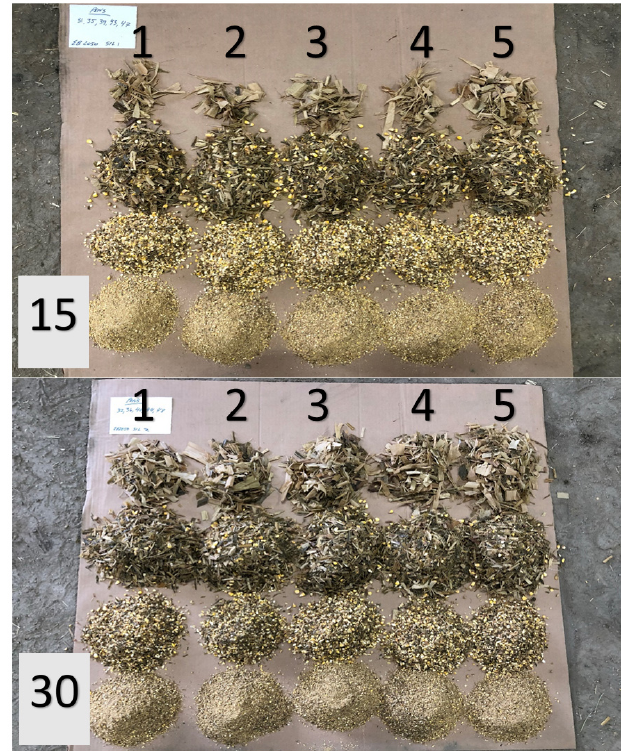
Figure 1. Visual illustration of the batch fraction (1, 2, 3, 4, or 5) and corn silage percentage (dry matter basis) fed (15 or 30) for the diets that were mixed for 20